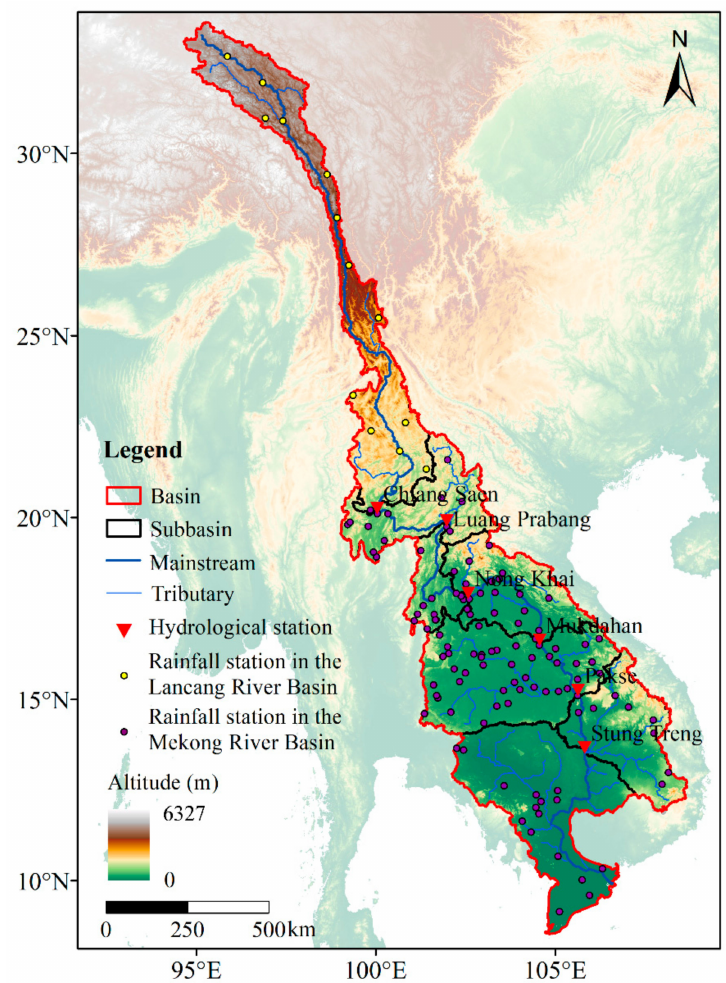
Figure 1. Topography, sub-basins, and the locations of rainfall and hydrological stations in the Lancang–Mekong River